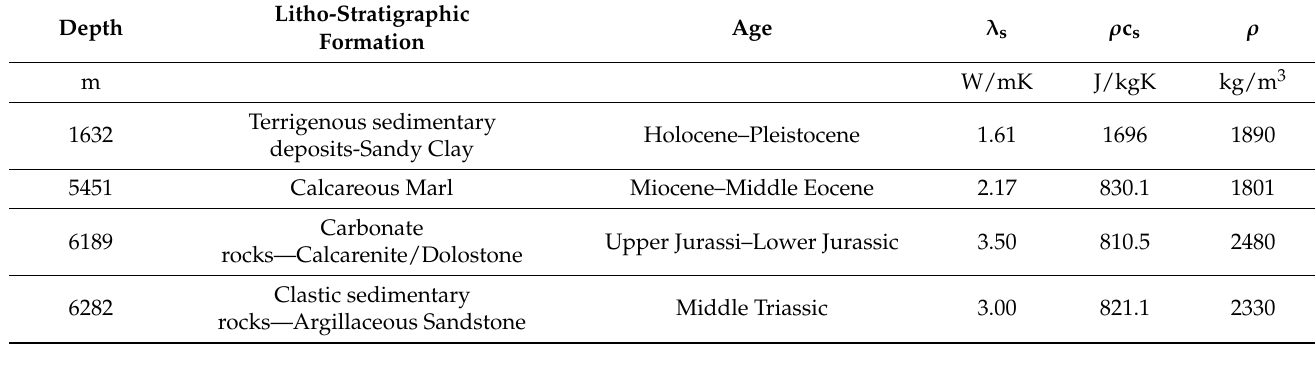
Table 1. Trecate4 hydrocarbon well-lithostratigraphic profile (Villafortuna–Trecate Oilfield, Western Po Plain). Depth